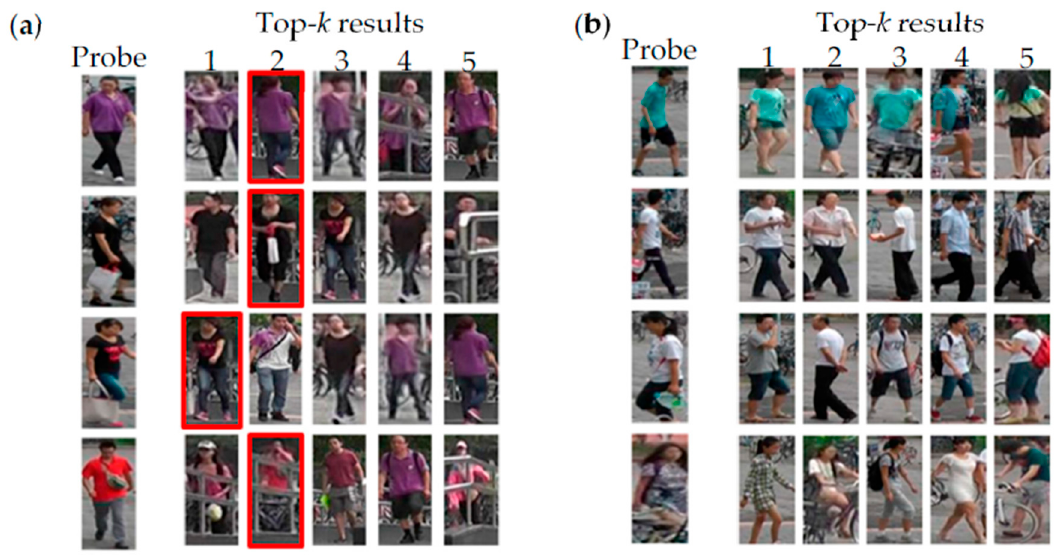
Figure 7. Examples of the identification results in Experiment 1 (identification network): ( a ) successful and ( b ) failure cases.